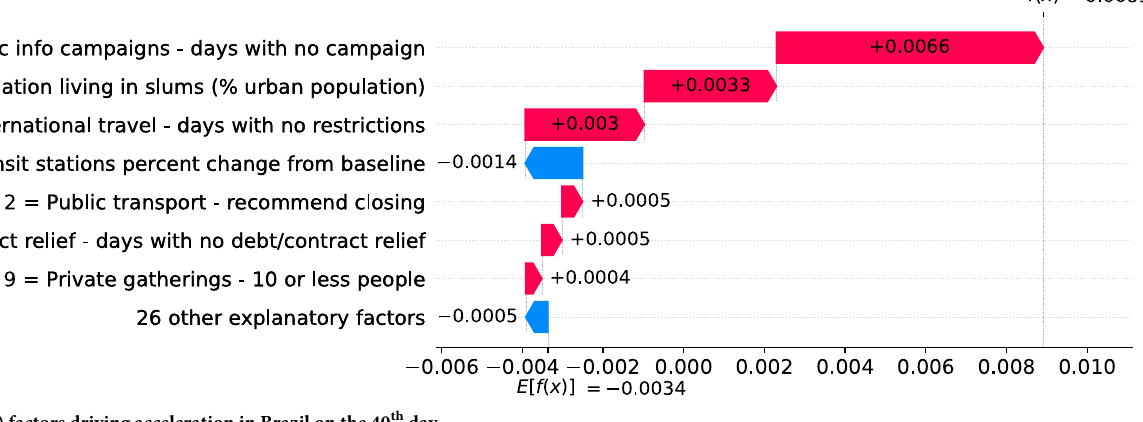
Fig 29. (Color online) factors driving acceleration in Brazil on the 40 th